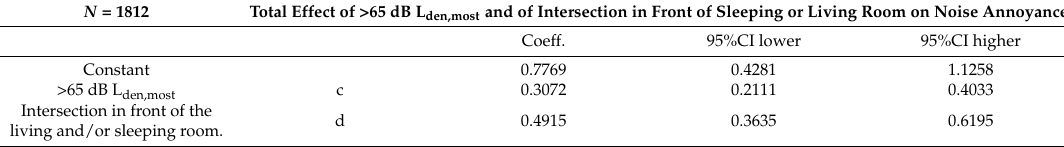
Table 5. Association of exposure to road traffic noise (>65 dB L den,most ) and absent quiet side (intersection in front of sleeping or living room) with perceived noise control and noise annoyance 1 .